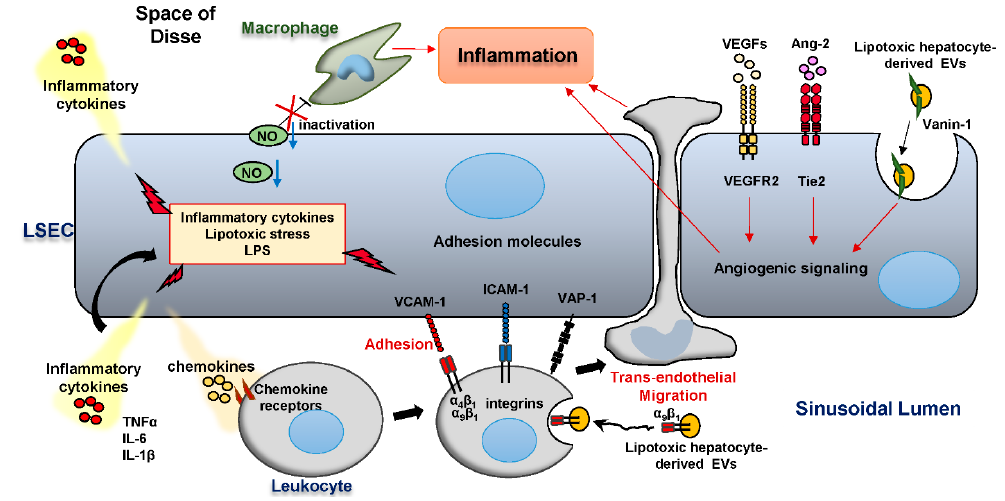
Figure 3. LSEC and hepatic inflammation in NASH.